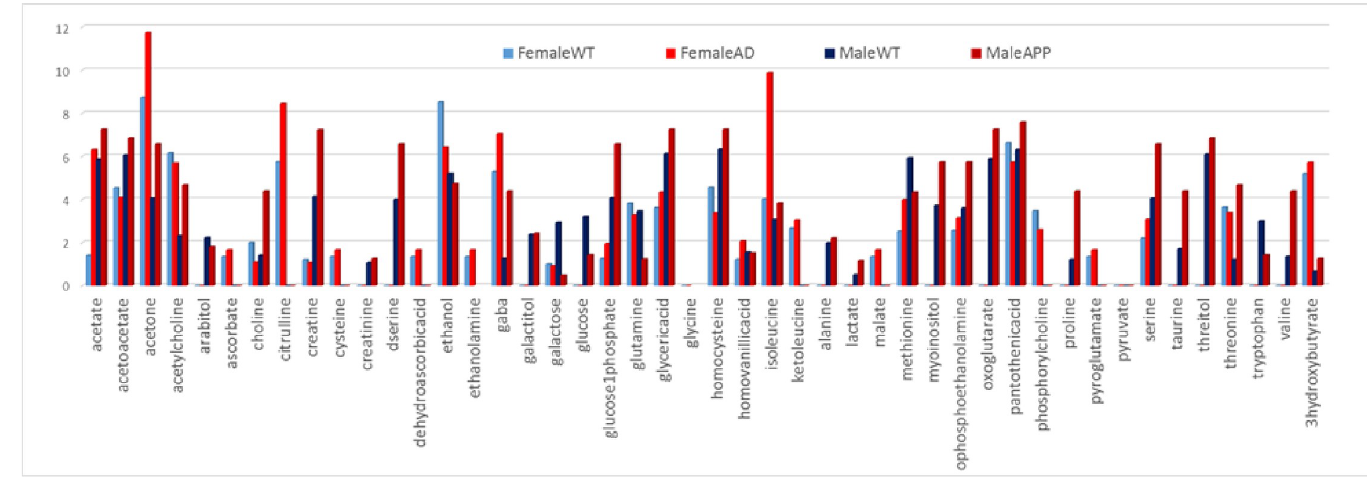
Fig 7. Ranking of metabolite correlation between blood and CSF with showing ranking of blood based metabolites.